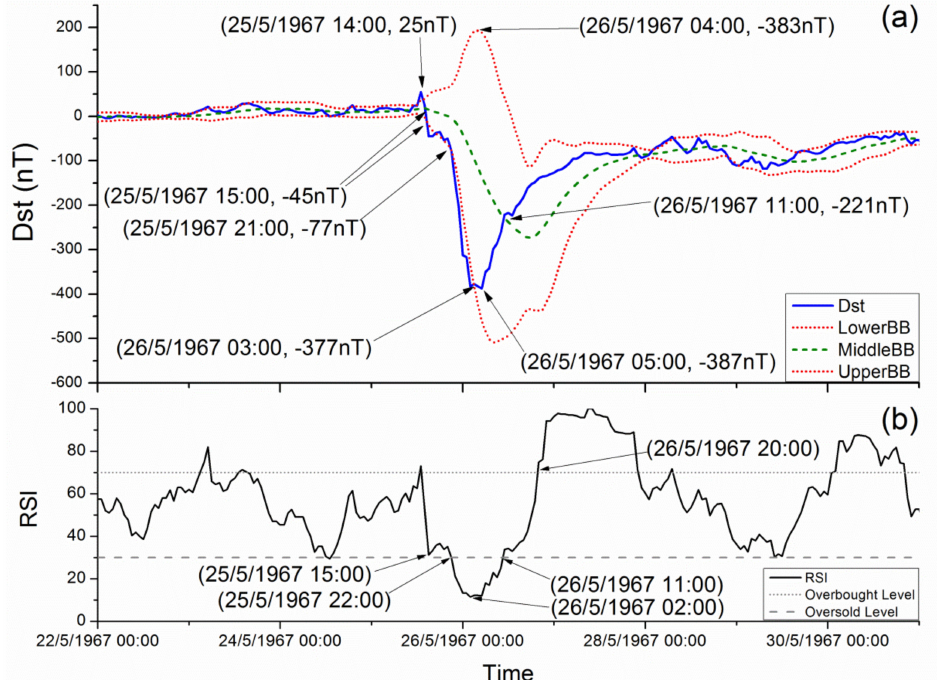
Figure 5. The evolution of an MS which occurred in 1967 in terms of ( a ) the SMA and Bollinger bands, and ( b ) the RSI indicator. The analyses results for a nine-day period from 22 May 1967 00:00 (UT) to 31 May 1967 00:00 (UT) are presented. The exact time and D st value for which specific features were found are marked on the figure using